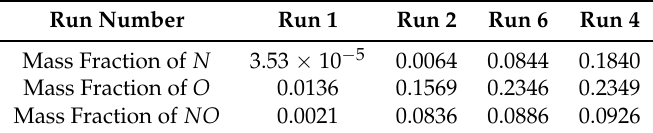
Table 4. Maximum of species mass fractions.